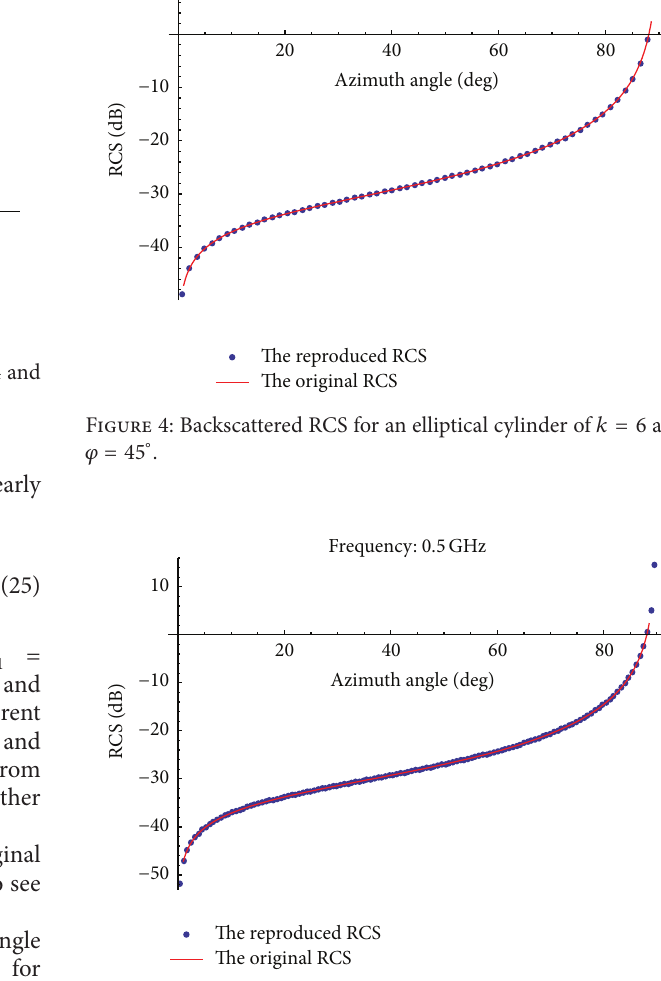
Figure 5: Backscattered RCS for an elliptical cylinder of 𝑘 = 7 and 𝜑 = 45 ∘